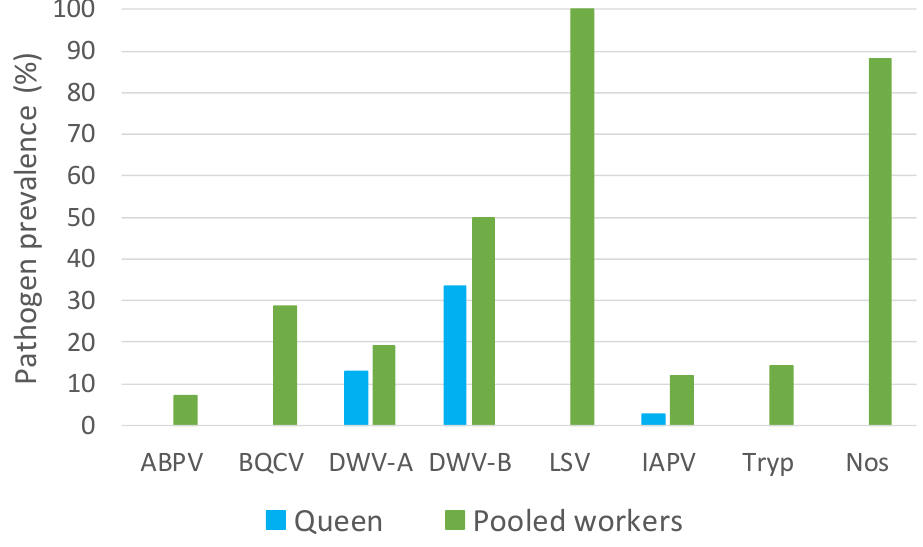
Figure2. Thepercentagesofpathogen-positivequeens(blue; n = 39)andpooledworkers (green; n = 42). Figure 2. The percentages of pathogen-positive queens (blue; n = 39) and pooled workers (green; n = 42). Both DWV-A and B variants were detected in higher viral loads compared to the other pathogens (ABPV, BQCV, IAPV, LSV, Trypanosomes, and Nosema; Figure 3). DWV-A was detected